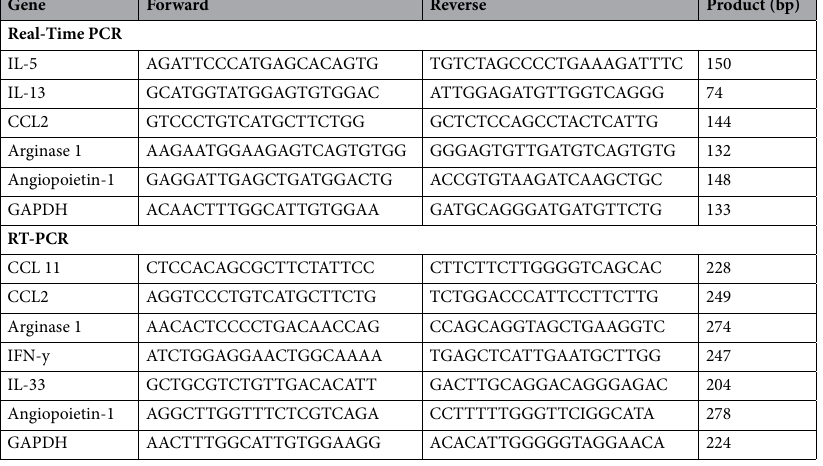
Table 1. Primers for real-time PCR and